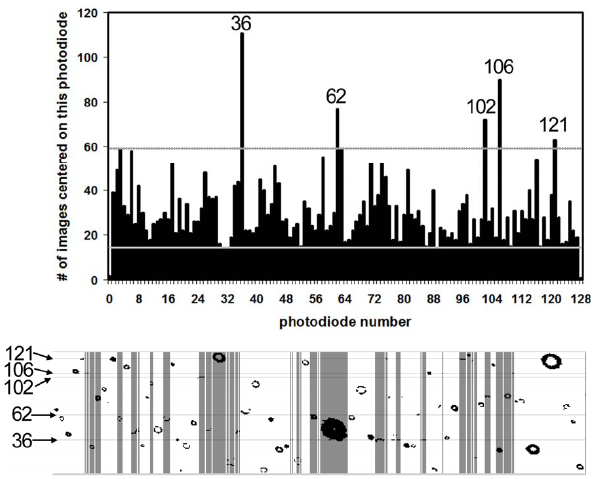
Figure B.2 . Example of noisy photodiode data intermixed with good particle data. The images highlighted in grey are rejected. Horizontal lines indicate the location of photodiodes determined to be noisy by the criteria described in the text and exemplified in the particle- center-location distribution shown above. The final step is another loop through the data to calculate the inter-particle spacings and reject particles that are close together. This algorithm is only performed if the current precipitation status is ‘yes’. The current precipitation status is ‘yes’ if there is one or more particle(s) with L7 > 100 µm in 10,000 particles accepted by the first two cleaning steps, centered approximately on the current particle. It is approximately centered because the